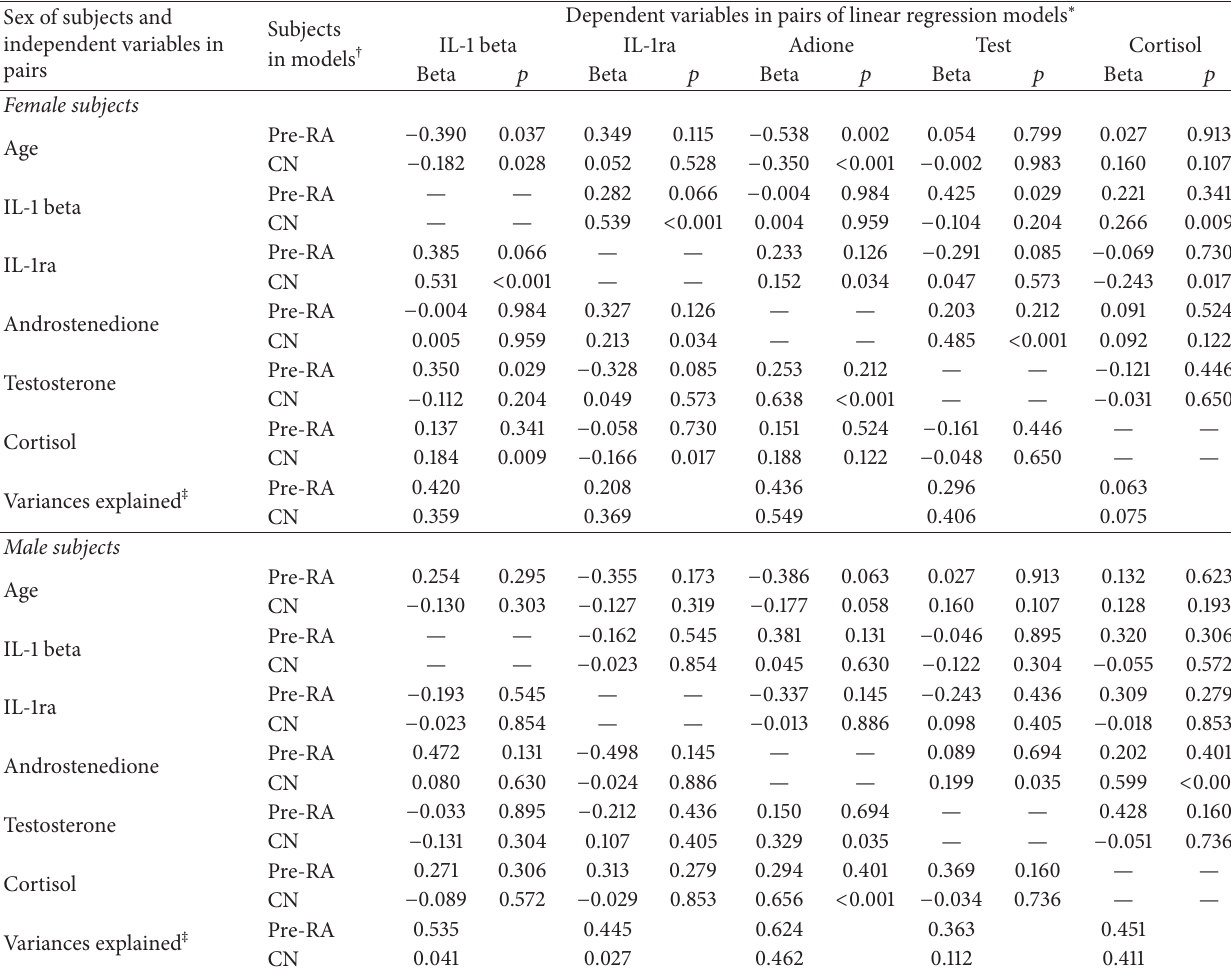
Table 7: Linear regression of standardized immunologic and steroidal